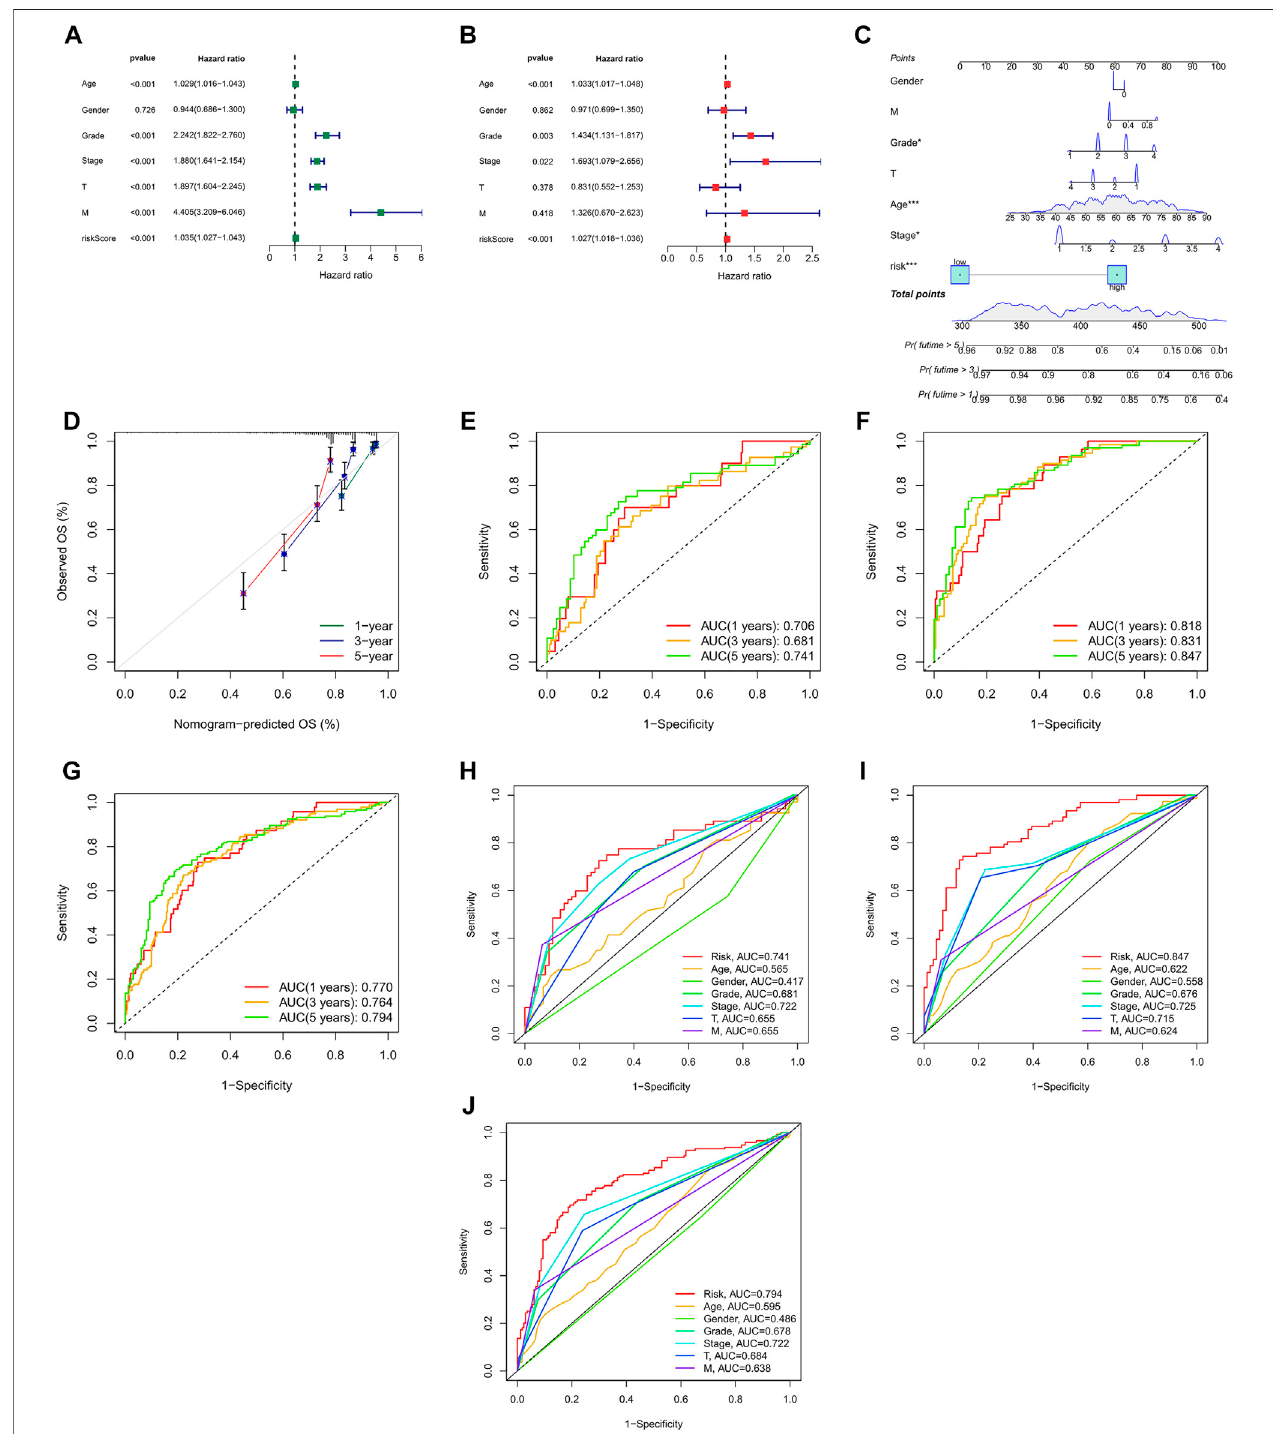
FIGURE5| Nomogramandassessmentoftheriskmodel (A,B) Uni-Coxandmulti-Coxanalysesofclinicalfactorsand riskscorewithOS. (C) Thenomogram that integratedtheriskscoreandclinicalparameterstopredictthe1-,3-,and5-yearsOSrate. (D) Thecalibrationcurvesfor1-,3-,and5-yearsOS (E – G) TheROCcurvesfor 1-, 3-, and 5-years OS rate of the test, train, and entire set, respectively, (H – J) The ROC curves for 5-years OS rate of risk score and clinical parameters.